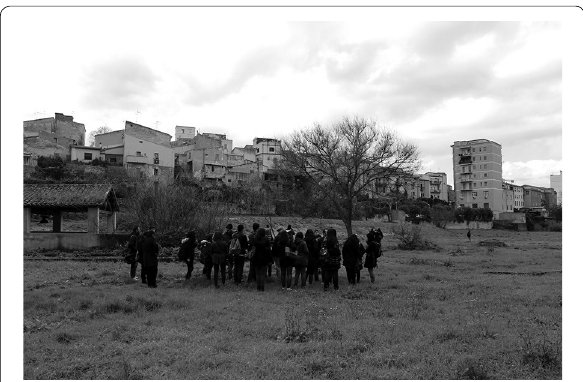
Fig. 3 Laboratory activities. Photo: R.